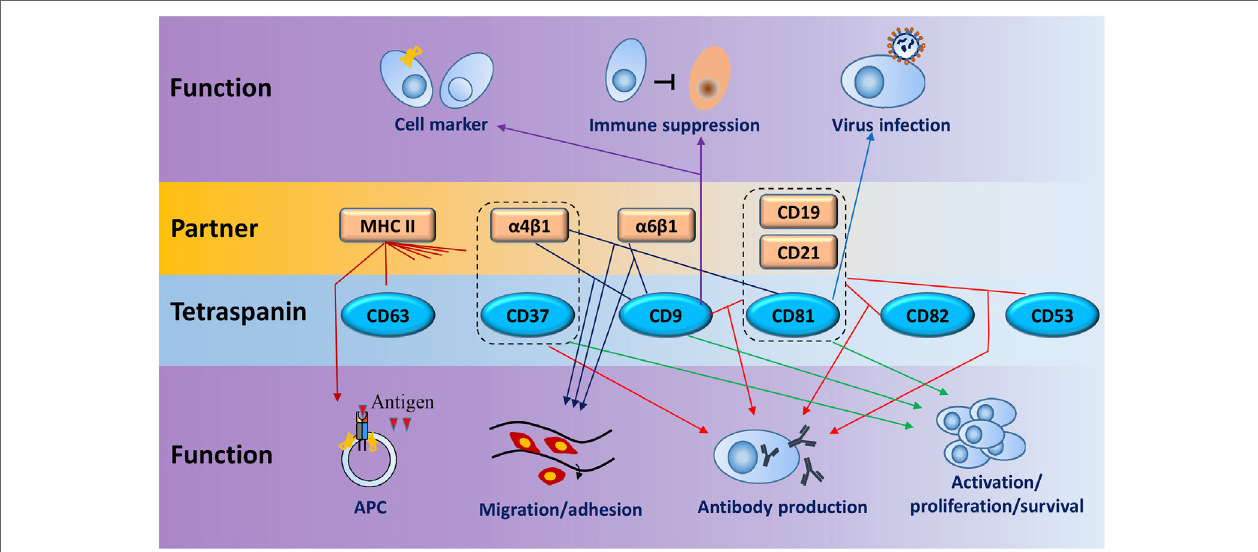
FiGURe 6 | Schematic diagram for main functions of tetraspanins and their partners in B cells. Dotted lines enclose coreceptors formed by tetraspanins and partners. Lines between tetraspanins and partners or coreceptors indicate the interactions which have functions in B cells (line with arrow) in seven biologic processes, such as cell activation, antigen presentation, and antibody production. One tetraspanin or partner can have one or more functions on B cells. Same colored lines with arrows point to similar function or regulation.